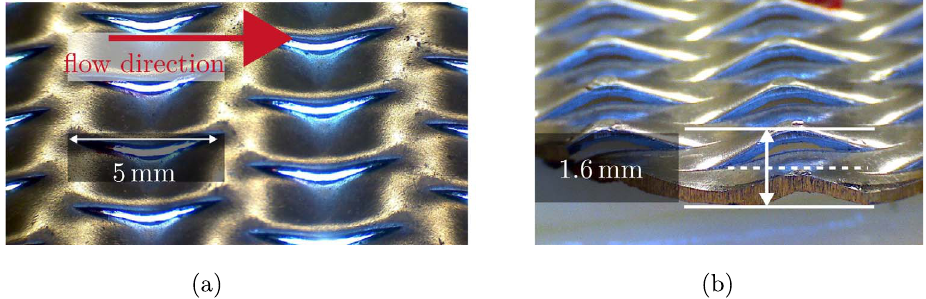
Figure 1. Micro-perforated sheet material: Acustimet ™ . (a) Top view of the MPP specimen. (b) Side view of the MPP